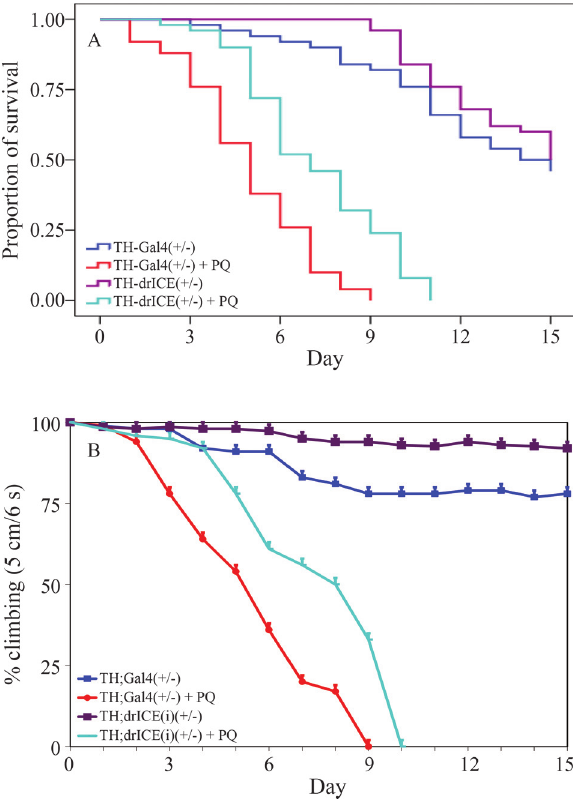
Figure 4 - DrICE gene knockdown increases life span and locomotor ac- tivity in Drosophila melanogaster exposed to paraquat. Female flies (n = 50 per treatment) were treated as described in Materials and Methods . The graphs show that the proportion of survival and climbing performance were significantly increased in TH-Gal4 +/- , UAS-drICE RNAi +/- gene knockdown flies compared to the TH-Gal4 +/- fly line (control). Statistical comparisonsbetweenuntreatedandtreatedfliesshowed:(A)ap<0.05by log-rank test and (B) a p < 0.05 by (cid:2) 2 test. Comparisons between treated geneknockdownfliesandthe TH-Gal4 +/- flylineshowedstatisticalsignif-